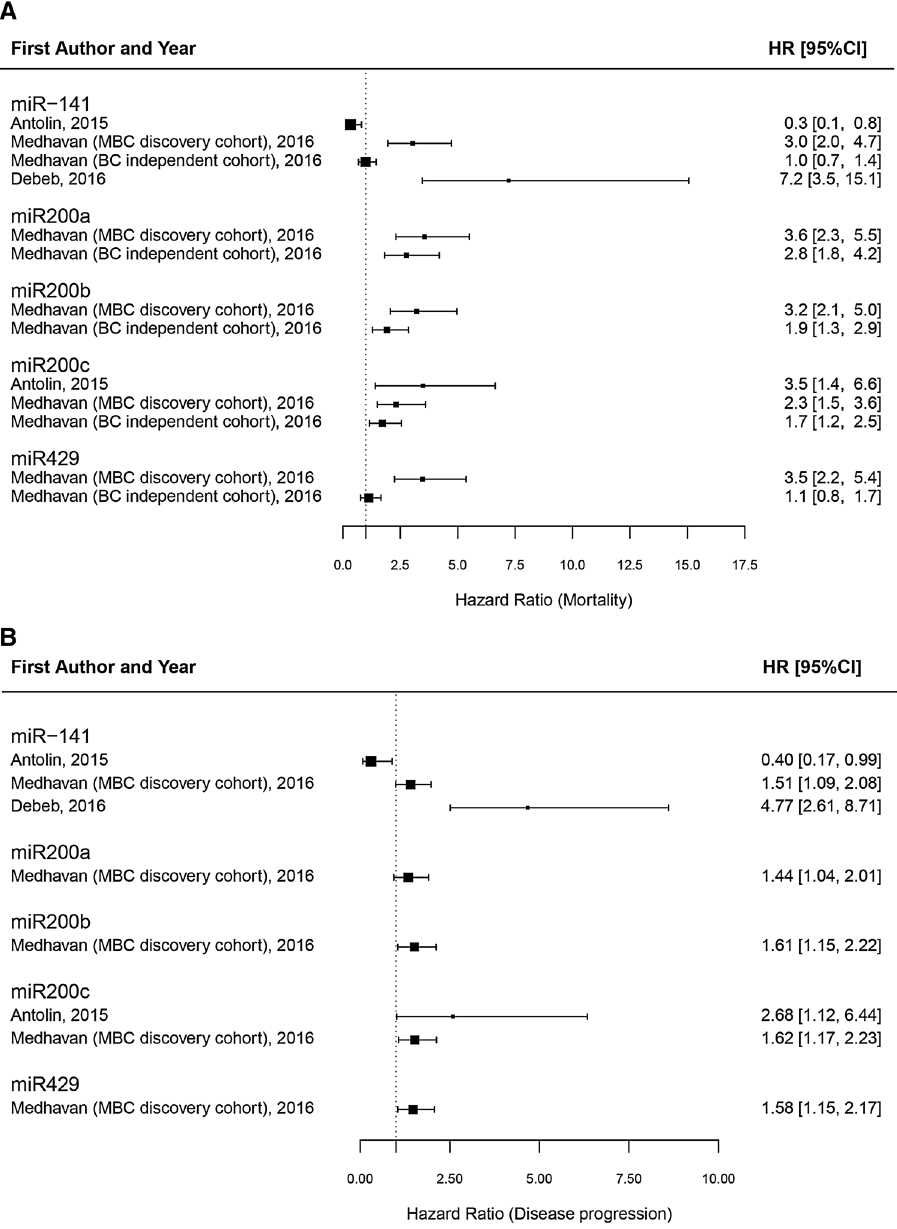
Figure 5. Forest plot of hazard ratios (HR) for studies on plasma samples from breast cancer patients. Plots were performed using the R Foundation for Statistical Computing (version 3.6, packages: ggplot2,